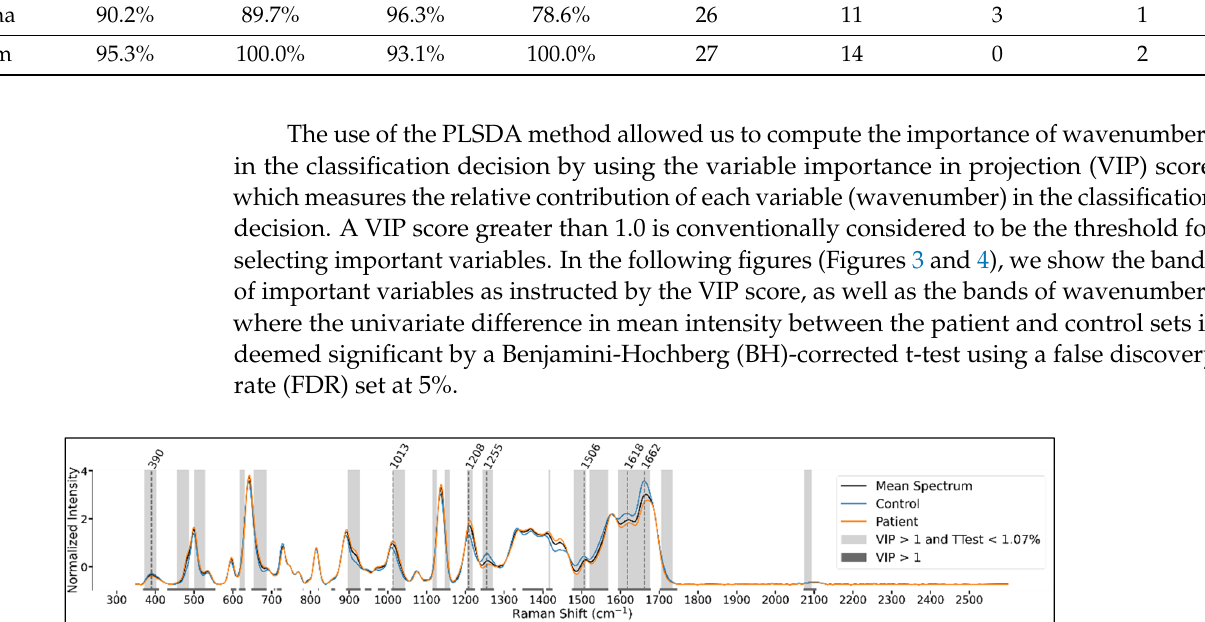
Figure 5. Mean spectra with emphasized t-test significance and VIP > 1 for serum samples.